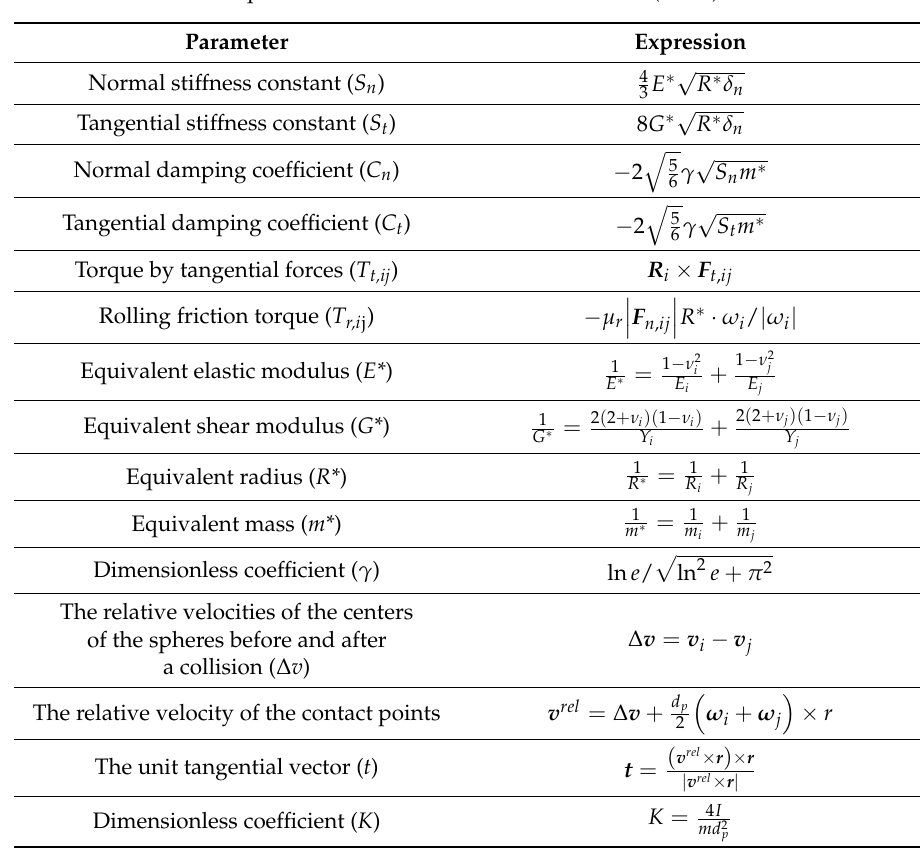
Table 1. Equations for the discrete element method (DEM)